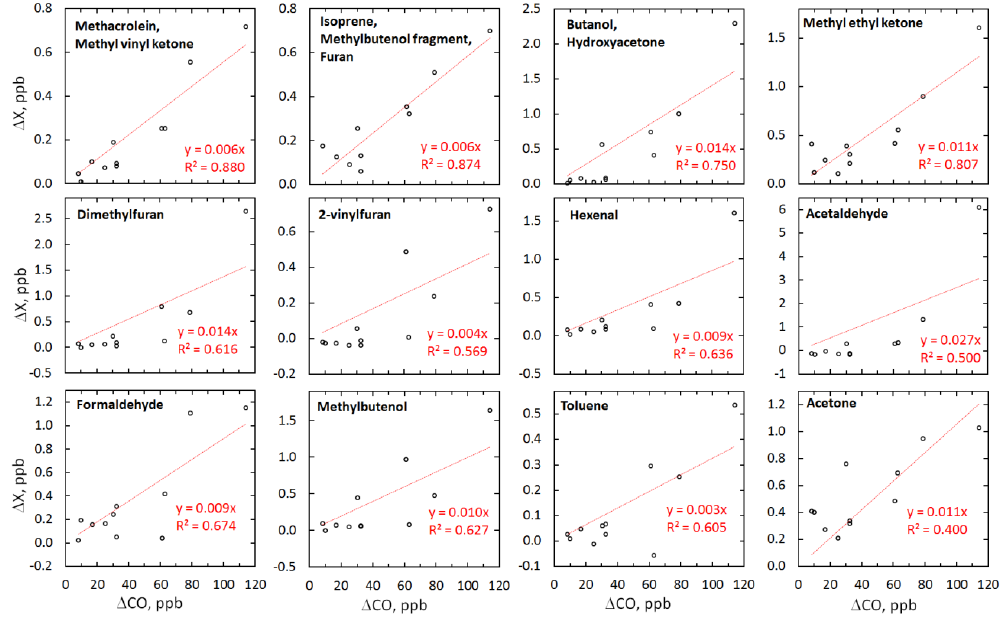
Fig. 8. Relationships of excess concentrations ( 1 X) of organic trace gases to excess carbon monoxide ( 1 CO) concentrations in the smoke plume peaks presented in Fig.